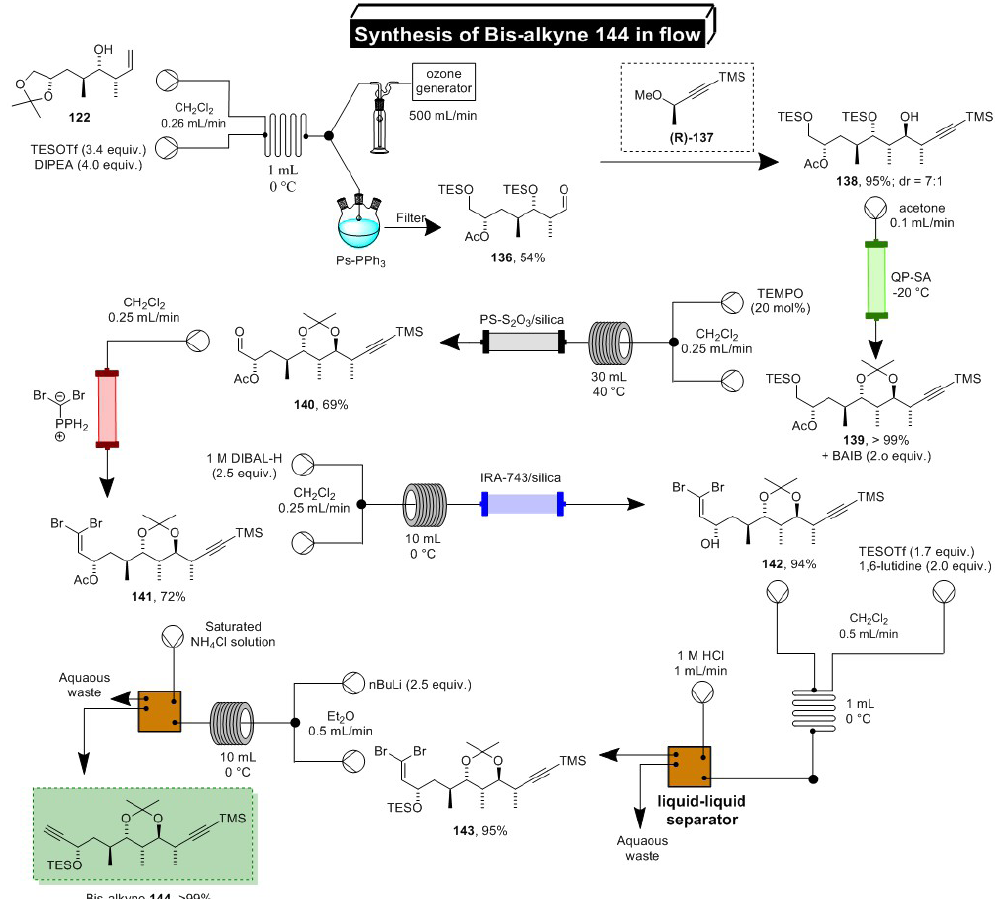
Scheme 32 - Continuous flow synthesis of the bis-alkyne 144 .